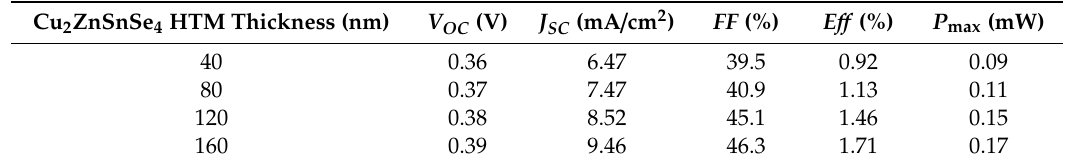
displays the graphic J – V curves of Ag/ZnS/MAPbI 3 /Cu 2 ZnSnSe 4 /Mo/FTO